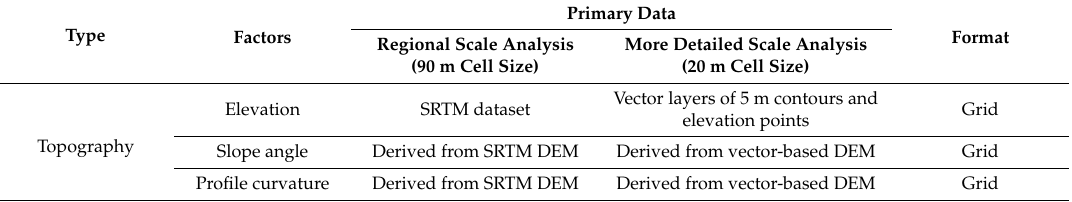
Table 1. Geographic Information Systems (GIS) Layers of the datasets representing the causal